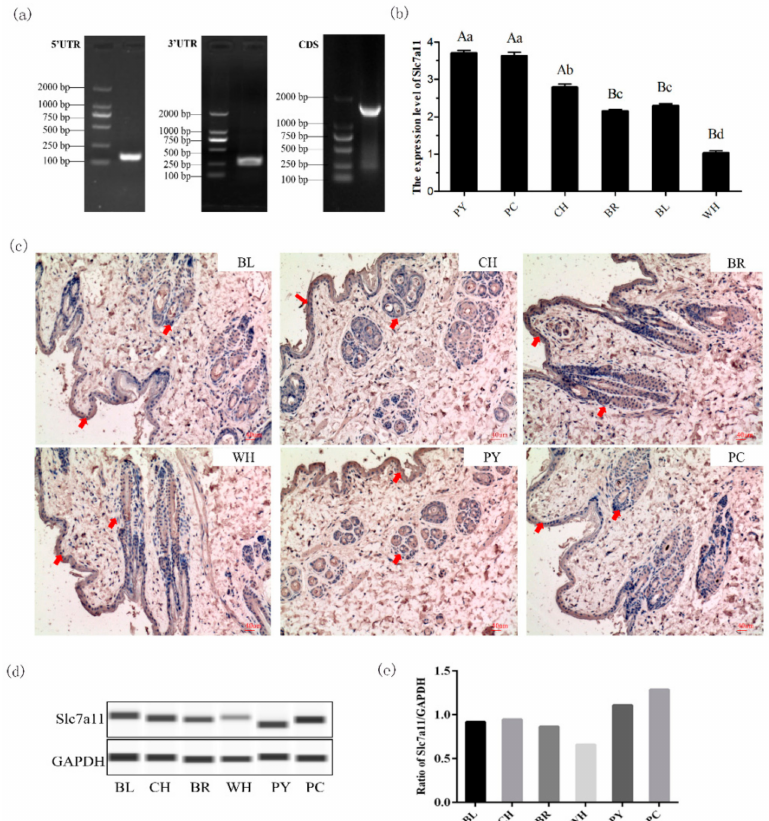
Figure 2. Cloning of rabbit Slc7a11 gene and its expression in Rex Rabbit coat with di ff erent fur colors. ( a ) Full length sequence of rabbit Slc7a11 cDNA was obtained using the RACE technique. The 5 (cid:48) UTR and 3 (cid:48) UTR sequences were obtained by 5 (cid:48) RACE and 3 (cid:48) RACE, respectively, and the DNASTAR program was used to assemble the sequence as well as remove redundant sequences to obtain the Rex Rabbit Slc7a11 cDNA sequence. ( b ) mRNA expression level of Slc7a11 gene in skin tissues of Rex Rabbits with di ff erent fur colors by Real-time PCR. Values with di ff erent capital letter superscripts signify an extremly significant di ff erence ( p < 0.01), and values with di ff erent small letter superscripts signify a significant di ff erence ( p < 0.05). ( c ) Localization of Slc7a11 in the skin of Rex Rabbits with di ff erent fur color using immunohistochemical staining. Arrows indicate positive expression of Slc7a11 in the epidermis and hair follicles ( × 100). ( d ) The expression level of Slc7a11 (xCT) in skin tissues of Rex Rabbits with di ff erent fur colors by the Wes method. ( e ) The results were analyzed using the Compass program and the relative expression ratio of Slc7a11 was